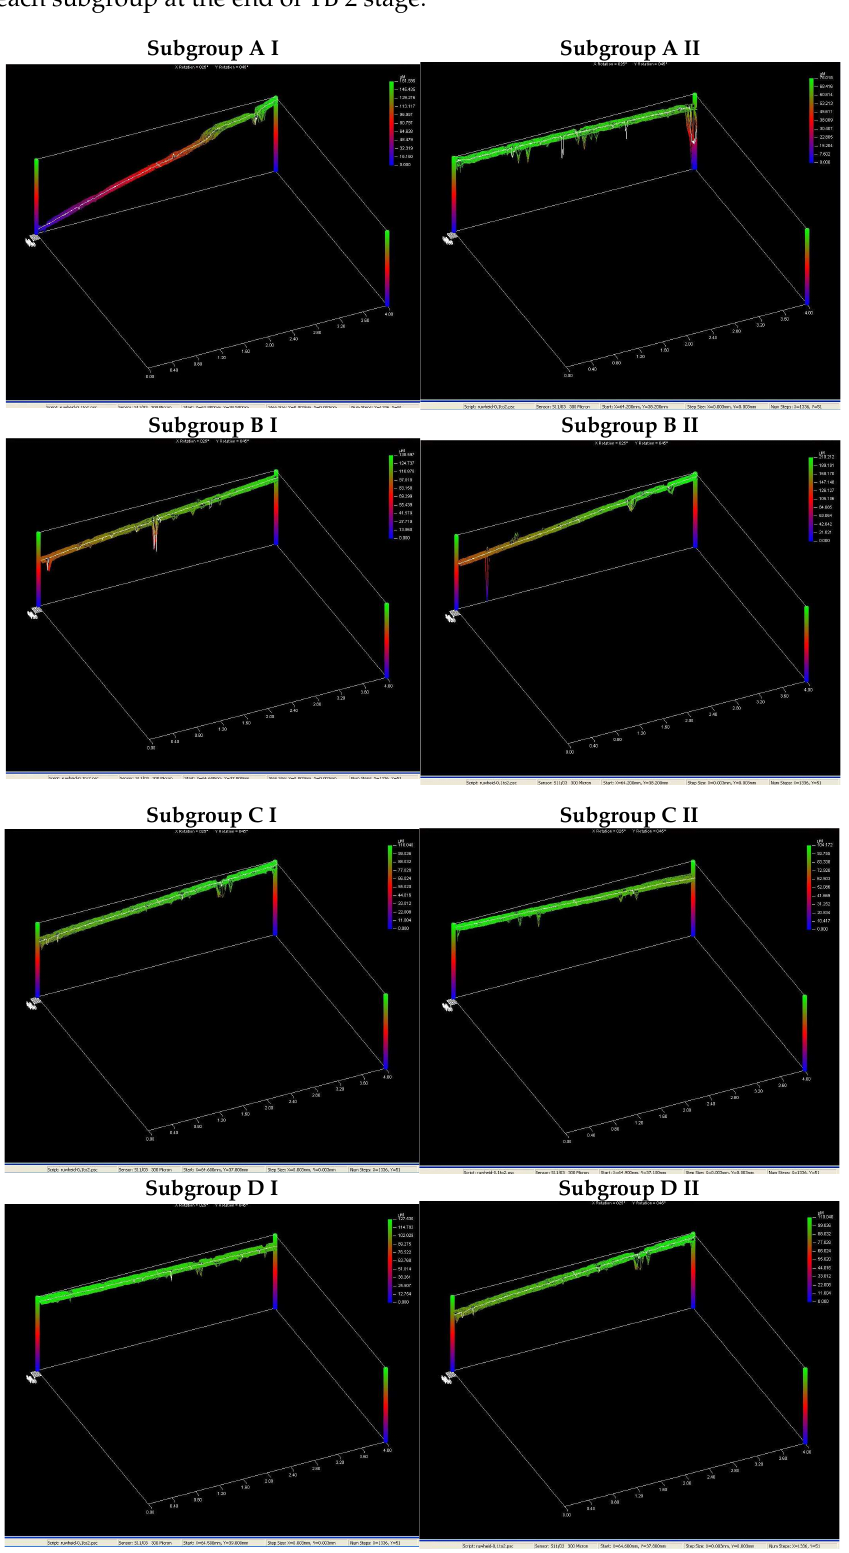
Figure 2. Profilometric measurements of some samples in each subgroup in stage TB2. The mean Ra values and standard deviation of the surface roughness of each subgroup in each stage is presented in the boxplot below (Figure 3).